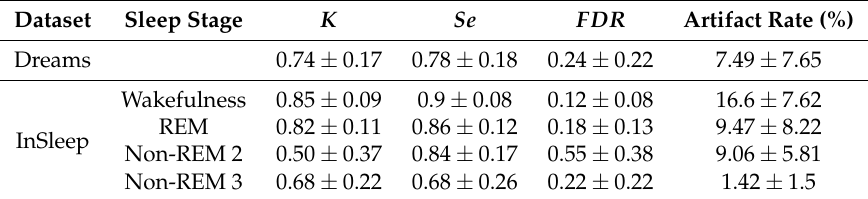
Table 3. Performance of RPs artifact